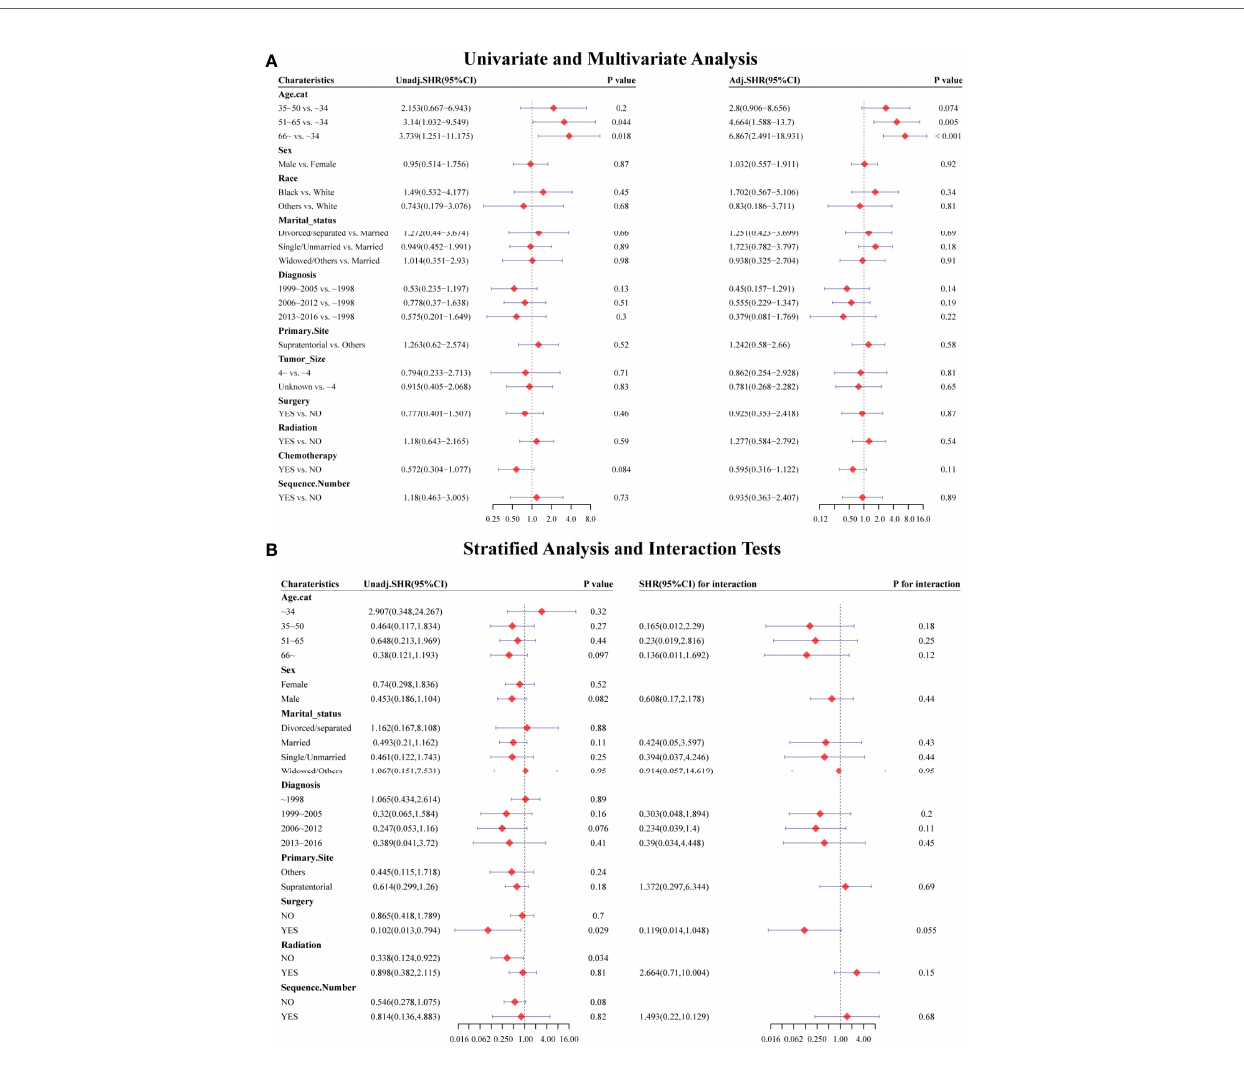
FIGURE 6 | Forest plots showed the results of ( A , left) univariable and ( A , right) multivariable analysis in the PSM-after cohort. Forest plots showed the results of ( B , left) strati fi ed analysis and ( B , right) interaction tests in the PSM-after cohort. SHR: subdistribution hazard ratio; CI, con fi dence